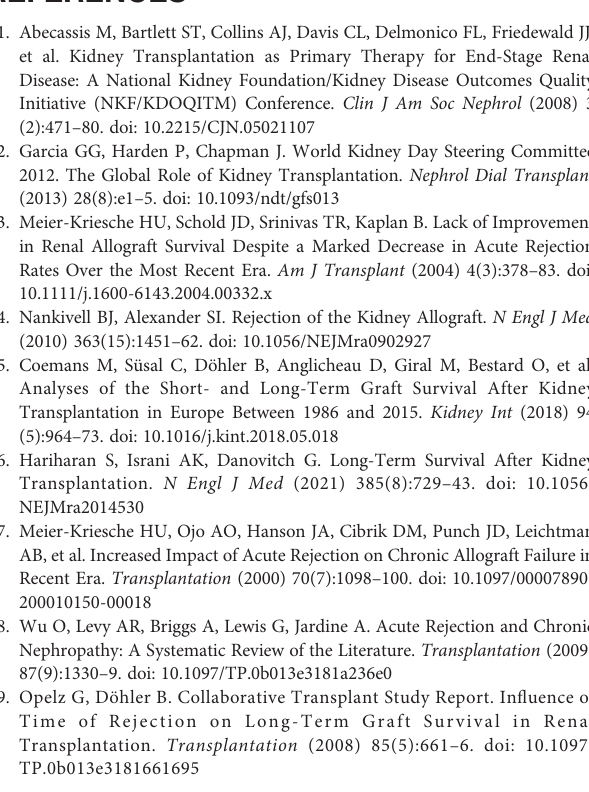
Supplementary Figure 5 | SLAMF8 and TLR4 are co-expressed in LPS plus IFN g treatedBMDMs.RelativemRNAexpressionofSLAMF8 (A) andTLR4 (B) were